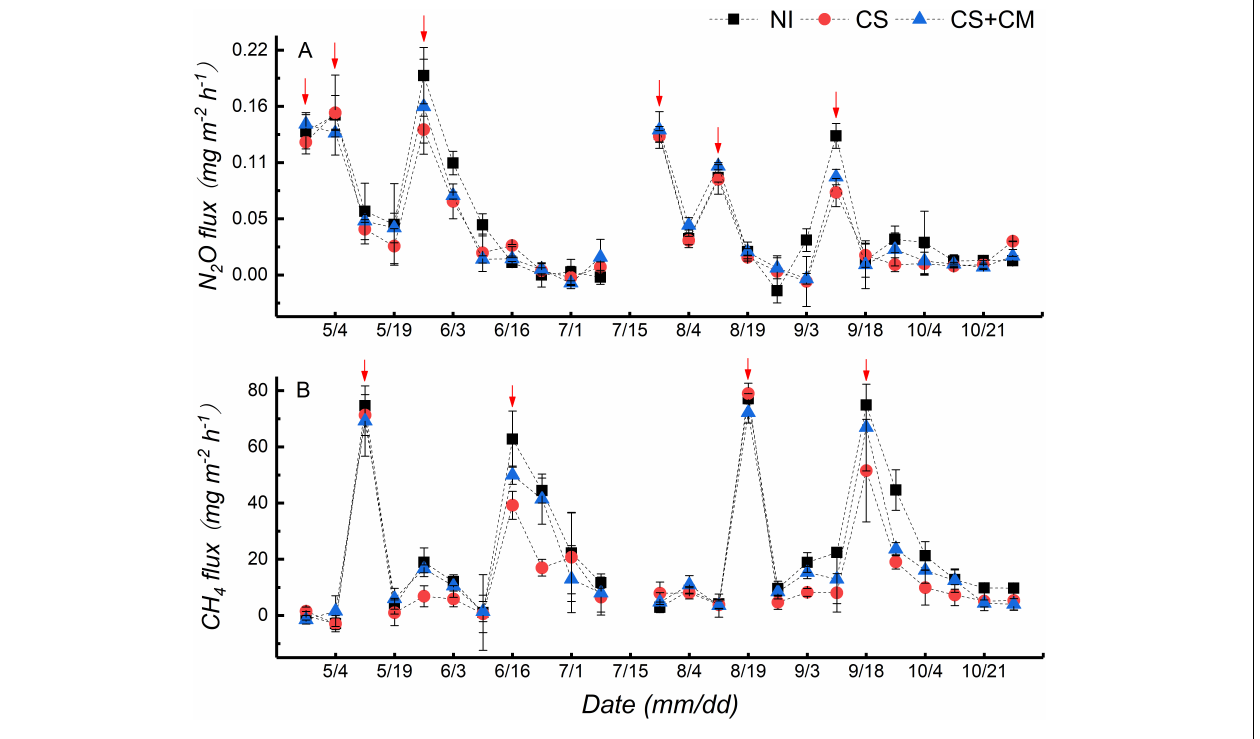
FIGURE 1 | N 2 O (A) and CH 4 (B) fluxes from paddy soil under different treatments throughout rice growing season in pot experiment. NI , no insect; CS , striped rice stem borers; CS + CM , striped rice stem borers + parasitoid wasps. Red arrows denote the peaks of N 2 O and CH 4